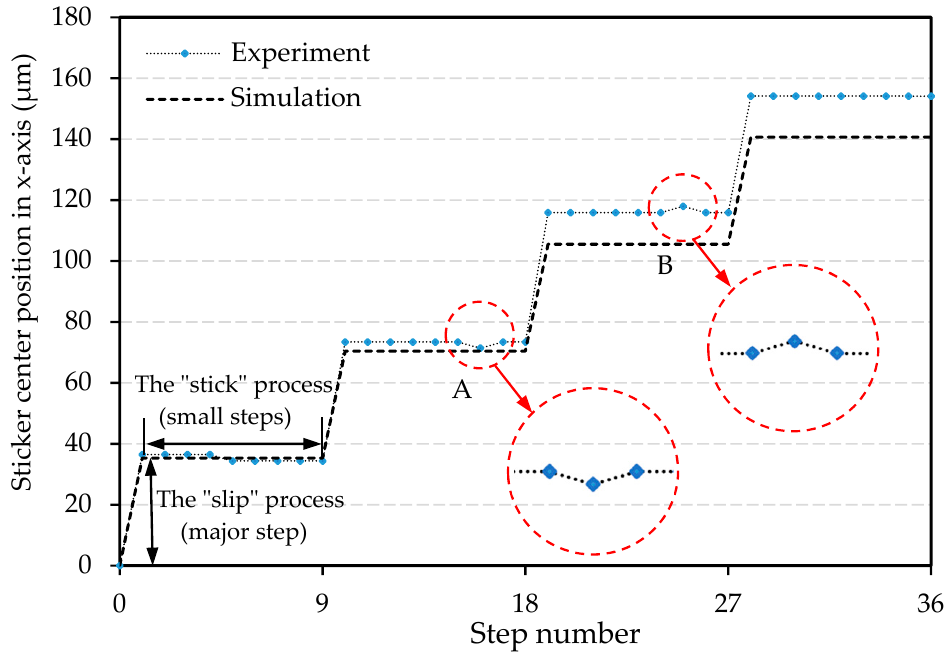
Figure 10. Influence of “stick” process.